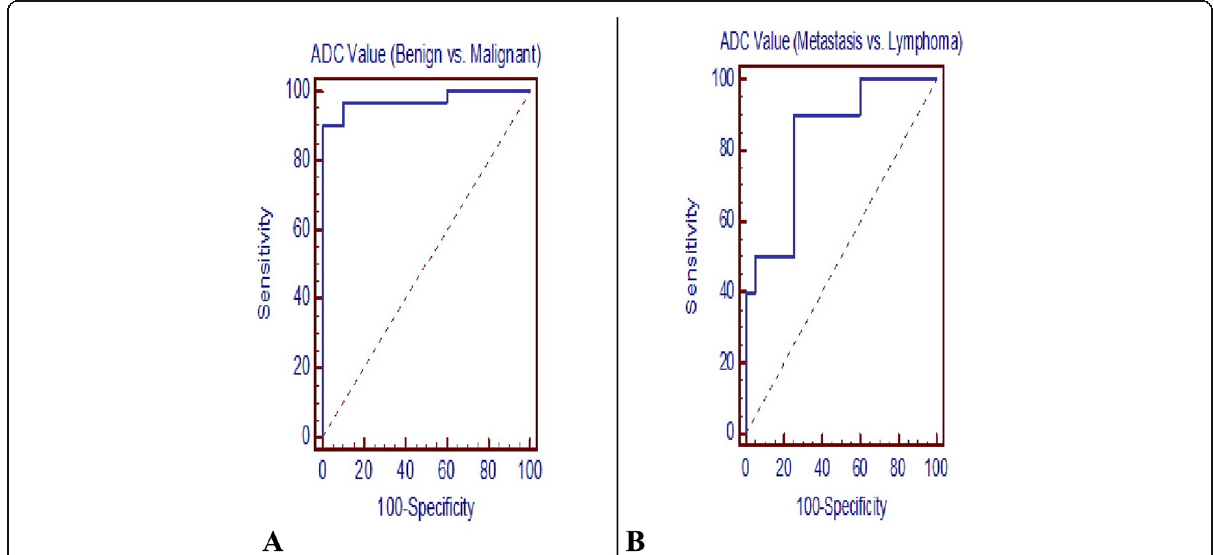
Fig. 5 a ROC curve analysis for ADC values in benign versus malignant LN. b ROC curve analysis for ADC values in metastatic versus lymphomatous LN